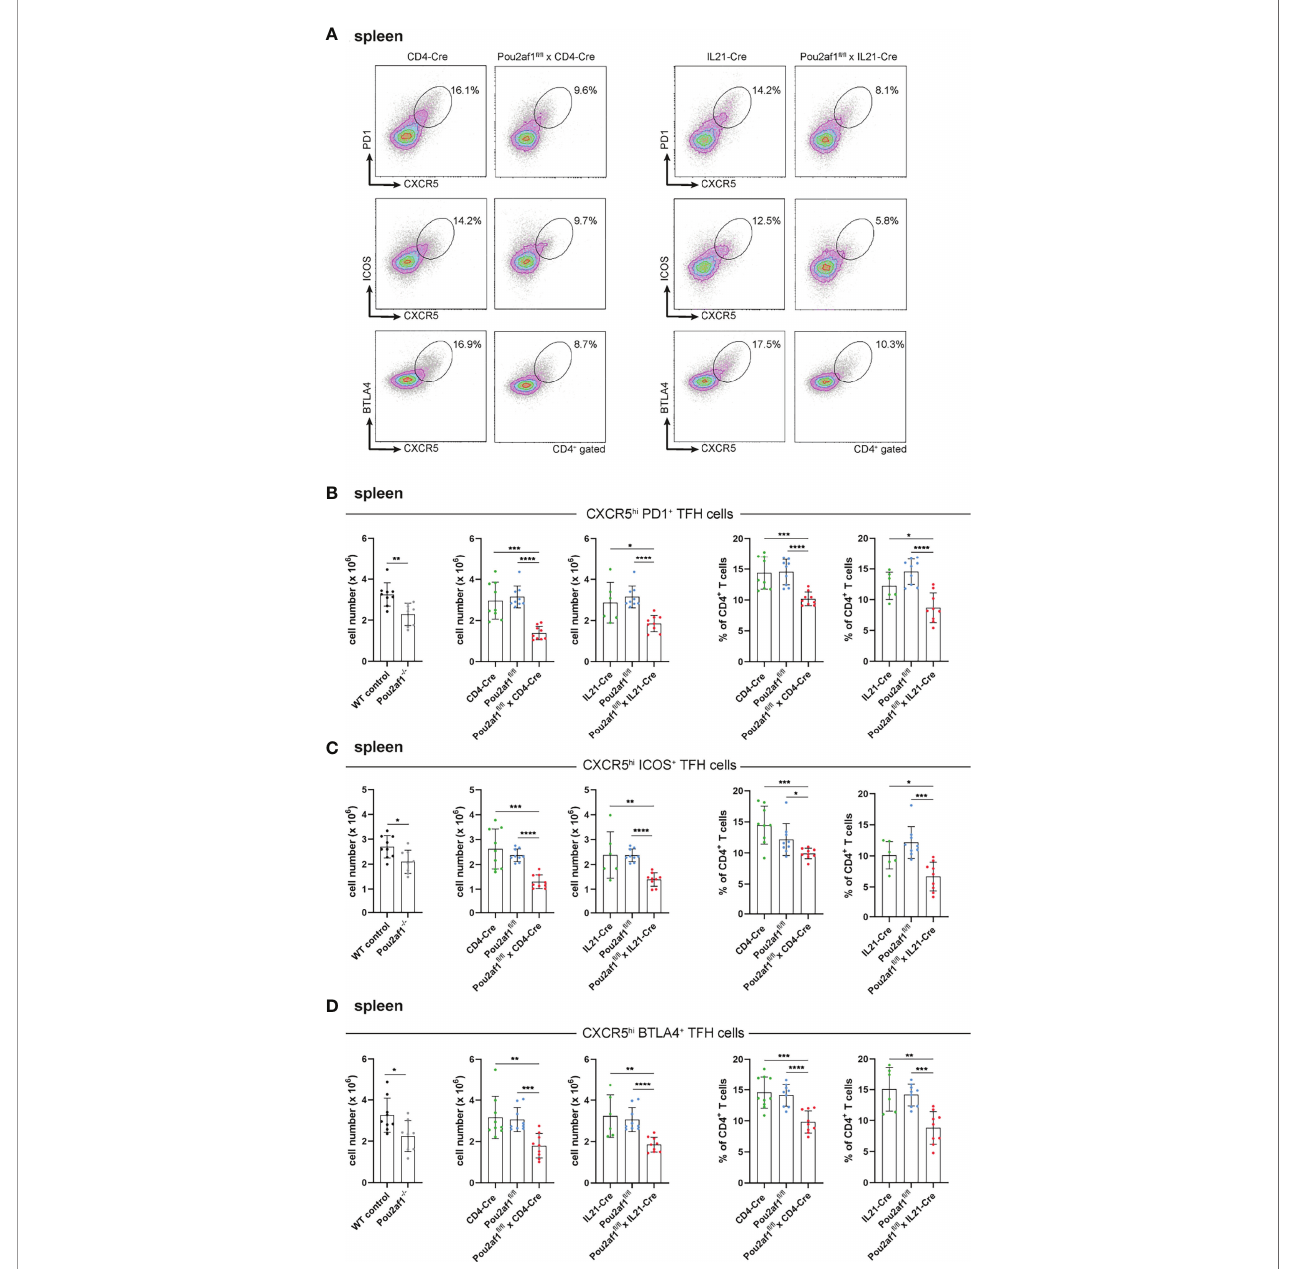
FIGURE 4 | BOB.1/OBF.1 is required for TFH cell development. (A – D) Representative fl ow cytometry plots (A) and statistical analyses of CXCR5 high PD1 + (B) , CXCR5 high ICOS + (C) and CXCR5 high BTLA4 + (D) TFH cell numbers (left panel) and TFH cell percentages (right panel) of CD4 + T cells in the spleen are shown. Gating strategy is shown in Figure S10 . Each point represents data from a single mouse. Data in the graphs are shown as means ± SD (n= 9 mice per group). Data are merged from two independent experiments. *p < 0.05, **p < 0.01, ***p < 0.001, and ****p < 0.0001. P-values were determined using a two-tailed Student ’ s t test or Mann-Whitney-U